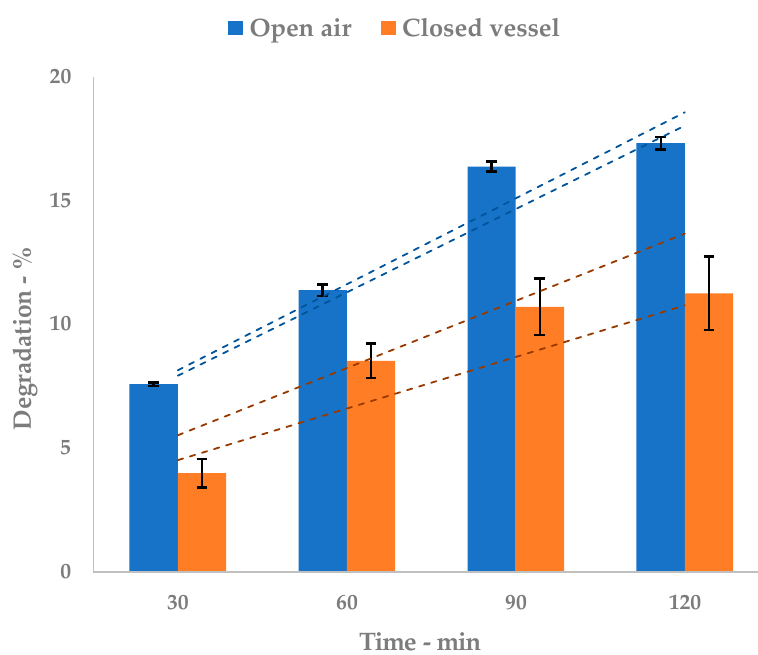
Figure 5. Sonolysis: influence of air. HPLC (open air) and NMR (closed vessel) quantification; dashed lines represent upper and lower SD envelopes.